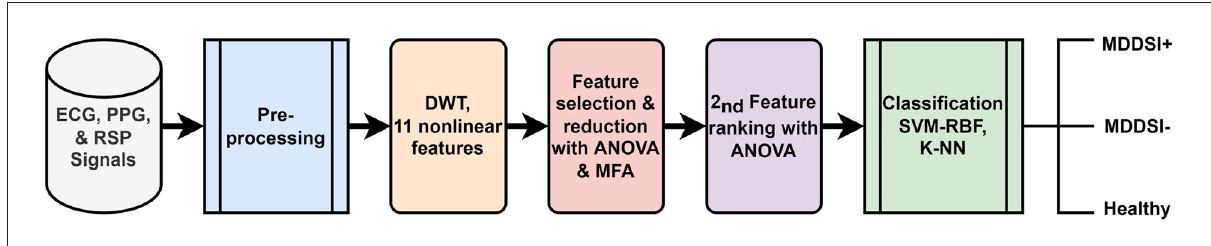
FIGURE1 Block diagram of the proposed framework for the recognition of MDD with SI from cardiovascular and respiratory